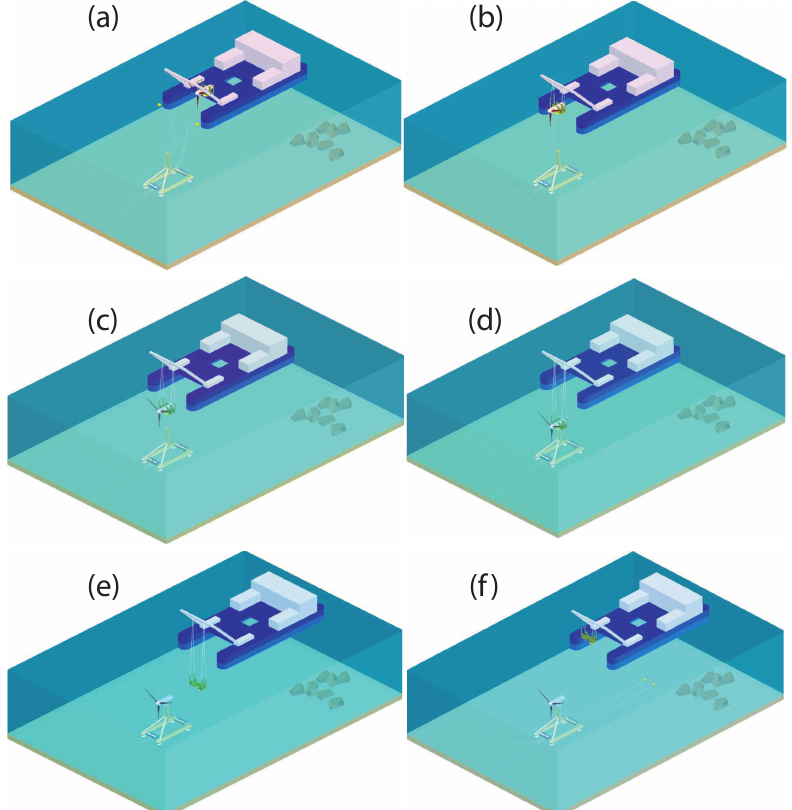
Figure 5. Installation of the gondola of the TECs: ( a ) cable-recovery process; ( b ) connection of the cables to the tool in charge of lowering the gondola; ( c ) controlled descent of the gondola; ( d ) process of inserting the gondola into the TEC structure; ( e ) tool and cable removal process; and ( f ) end of gondola-installation